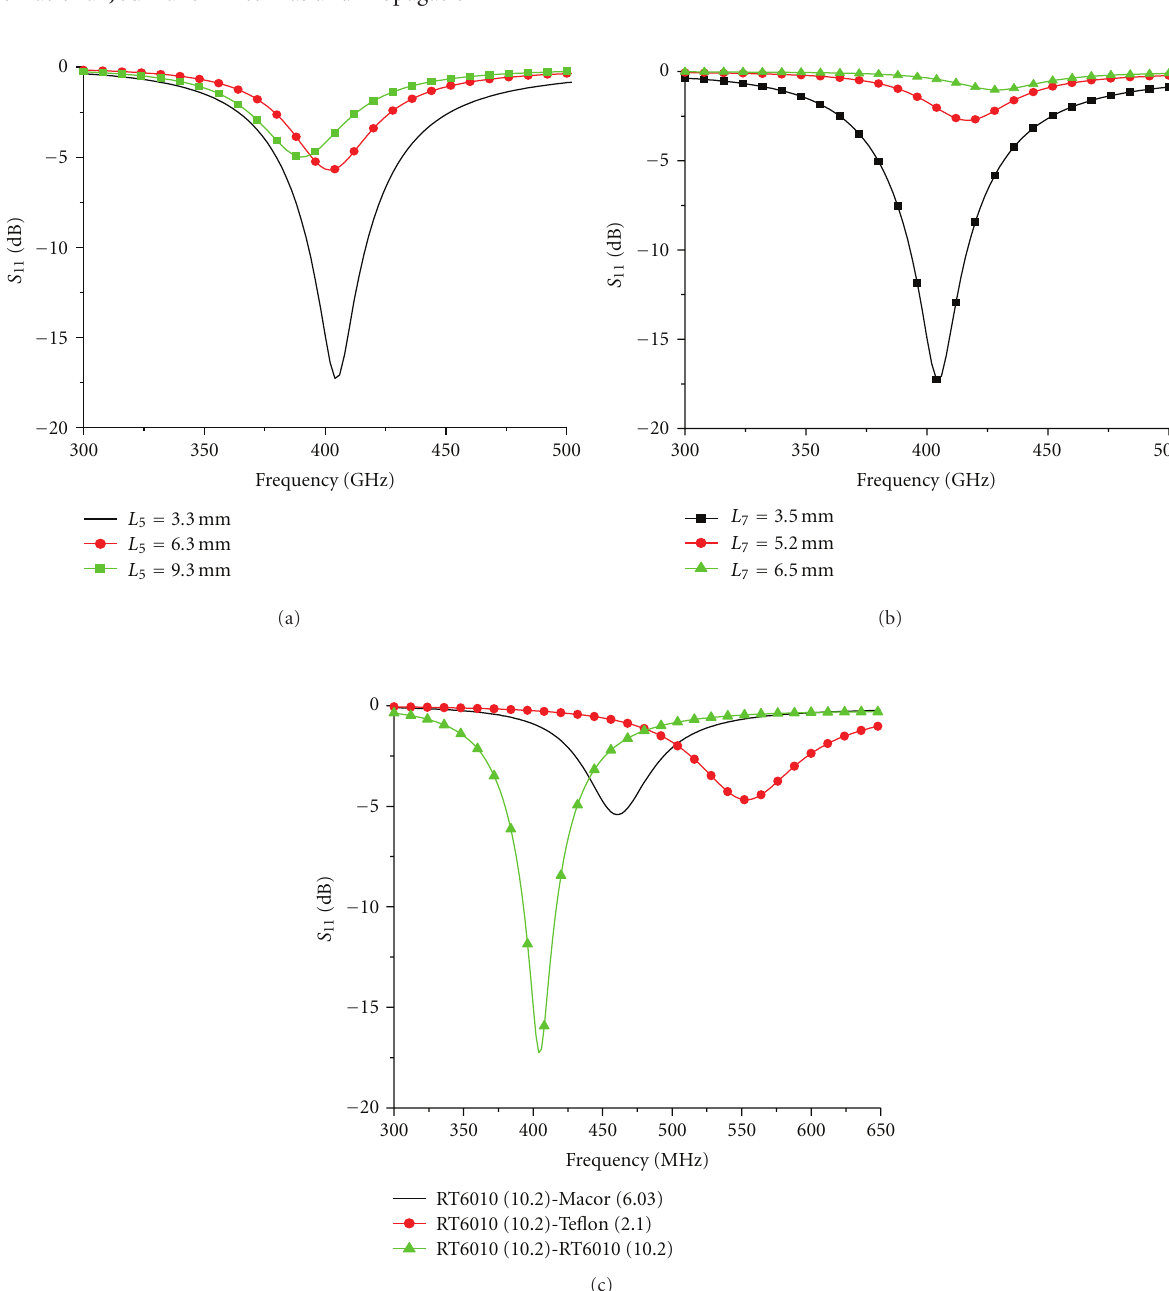
e ffi ciencies at 1 meter from the center of antenna are obtained. It can be found that when superstrate and substrate are both Rogers RT6010, the highest e ffi ciencies are achieved in both